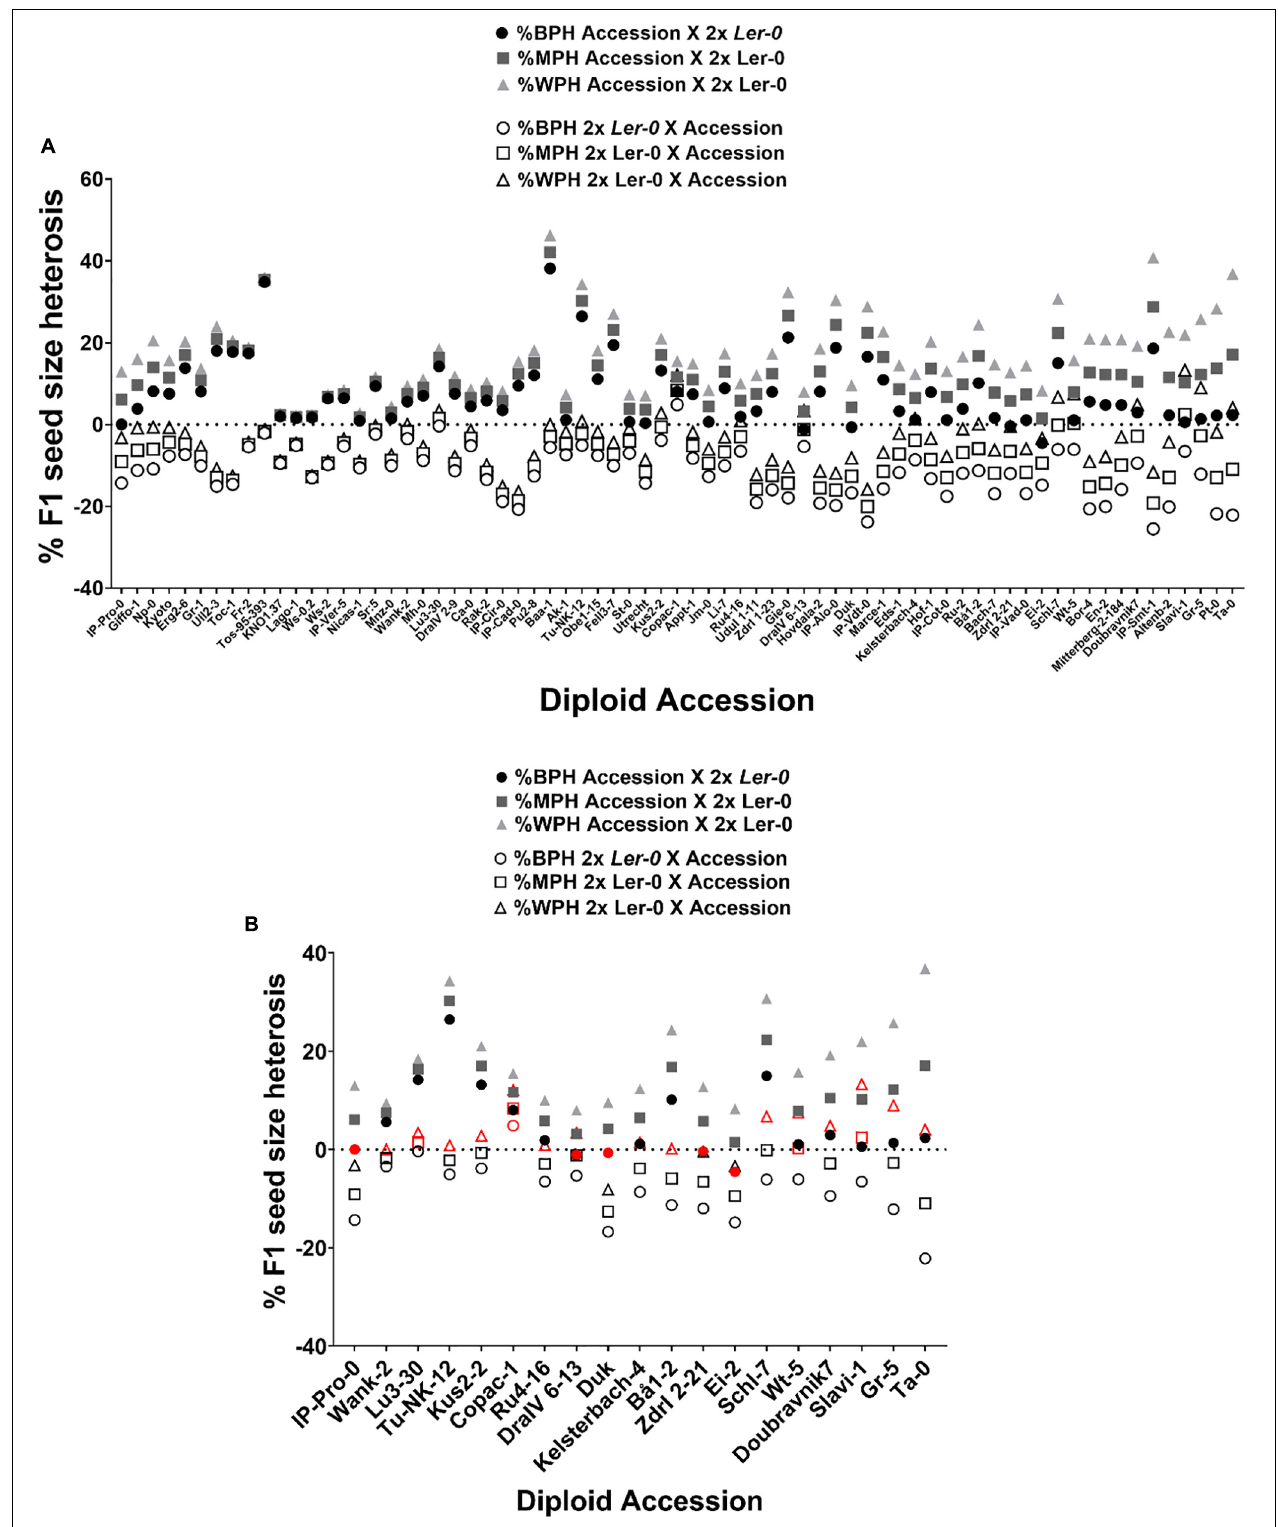
FIGURE 3 | The heterotic effect on F1 diploid seed size depends on parent-of-origin effects. (A) Levels of Best-Parent (%BPH), Mid-Parent (%MPH) and Worst-Parent Heterosis (%WPH) across reciprocal F1 hybrid diploid seed size. (B) F1 hybrids that do not follow the trend observed among 71 reciprocal L er -0/Accession F1 hybrids for %BPH, %MPH or %WPH. Exceptions are indicated in red. The horizontal dotted line represents the critical value 0.